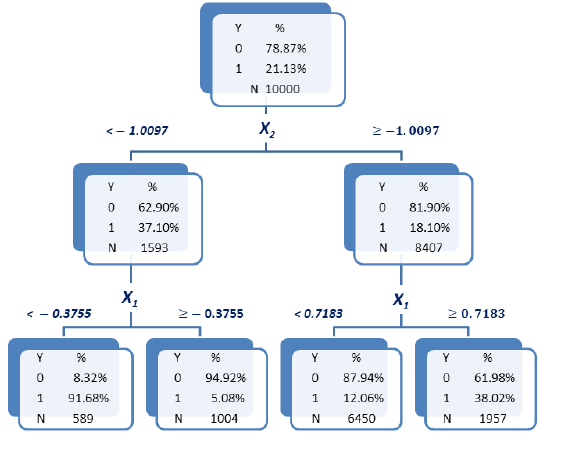
Figure 3. Classification tree grown using variables X 1 and X 2